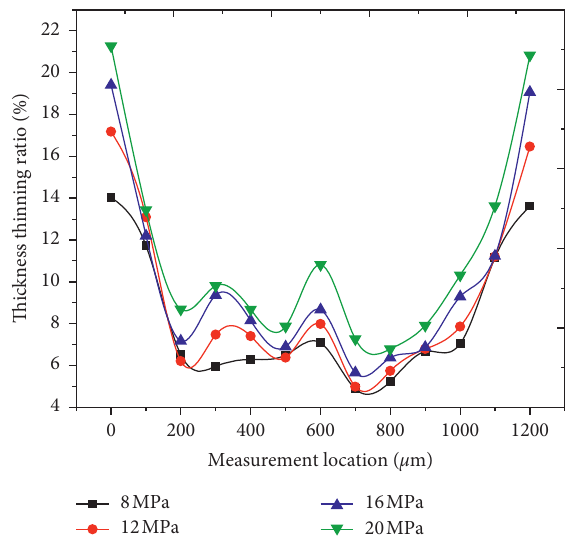
Figure 10: Distribution of thickness thinning ratio.